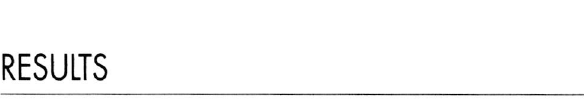
Specimens have been deposited in the South Austra lian Museum, Adelaide, South Australia (SAM), the Muséum National d'Histoire Naturelle, Paris (MNHN) and the Natural History Museum, London